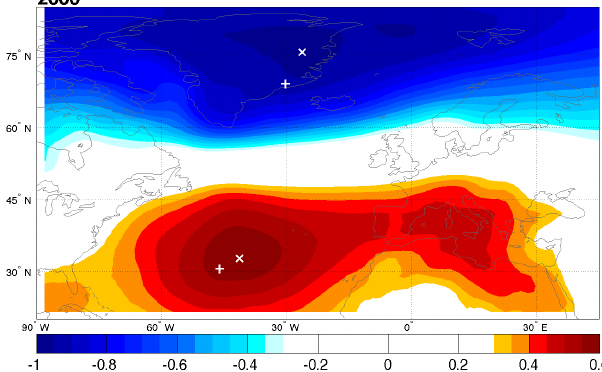
Figure A1. Correlations between North Atlantic winter SLP (December–February) and the PC1 of SLP. The markers indicate the maxima in CI ( + sign) and in the SLP/PC1 ( x sign) correla-